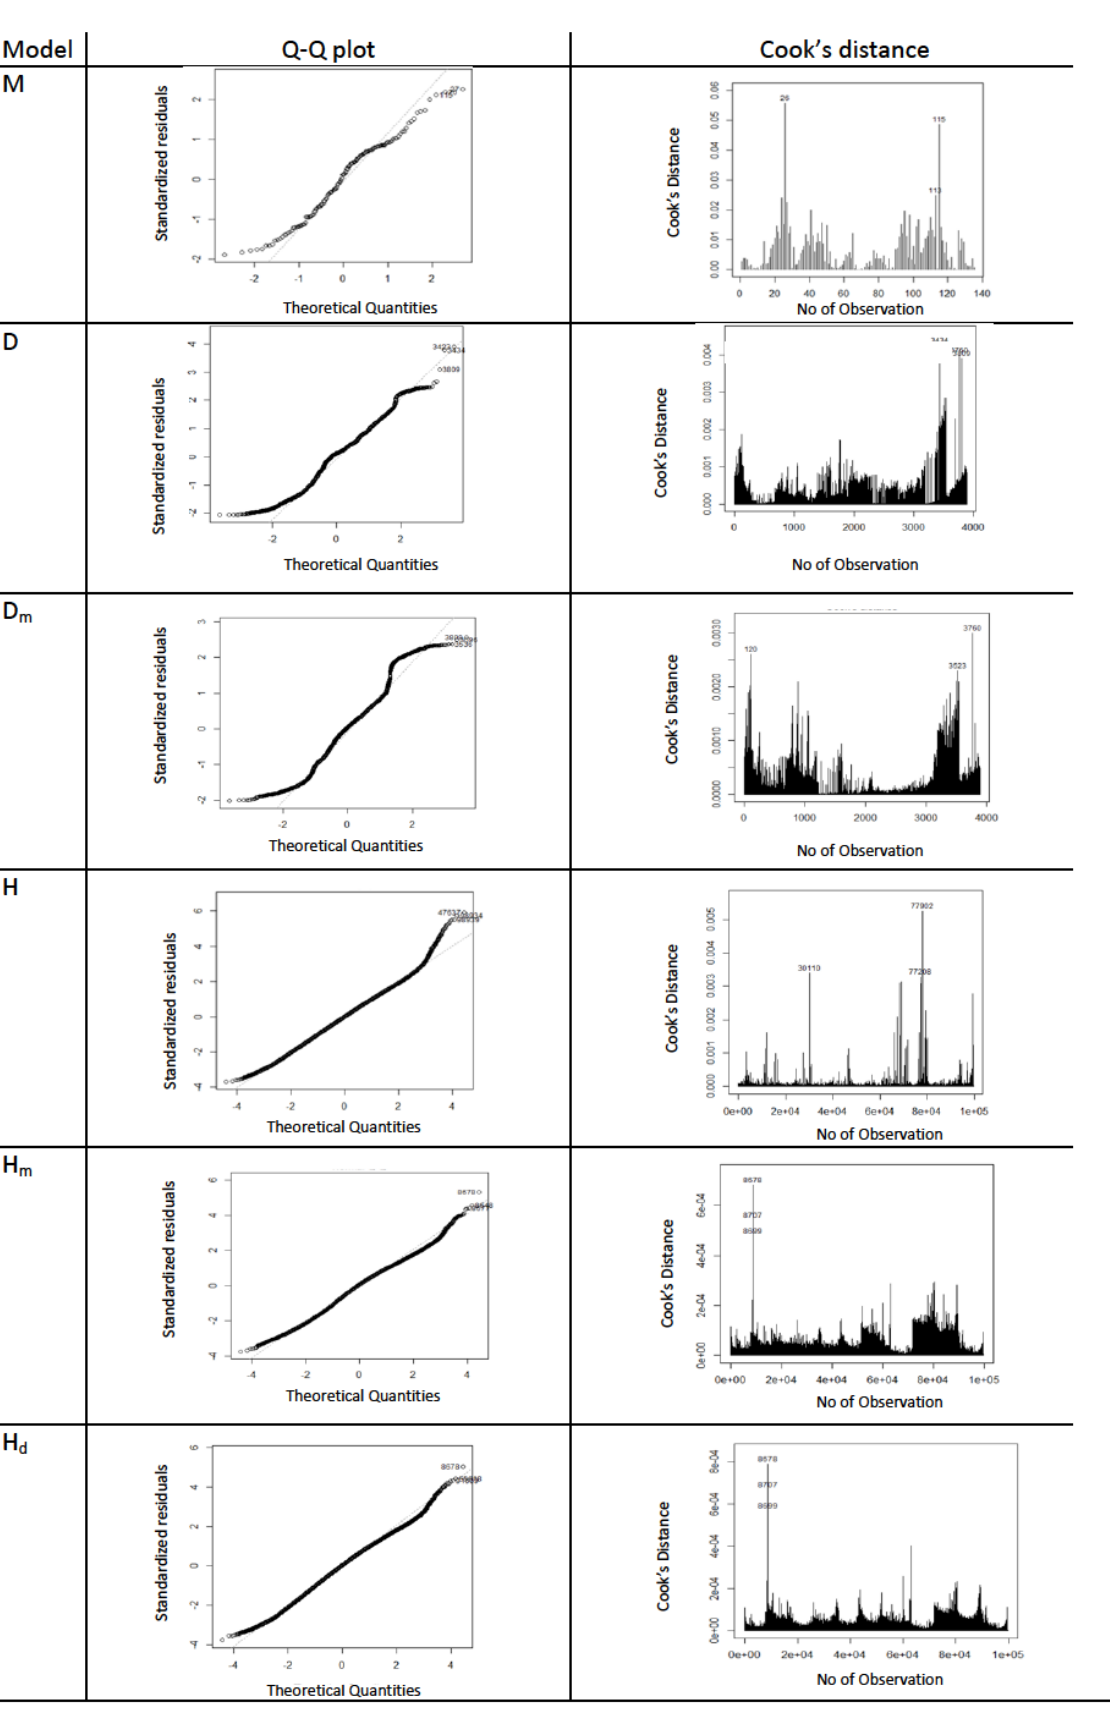
Supplementary Figure 4: Q-Q plots and Cook’s Distance for all